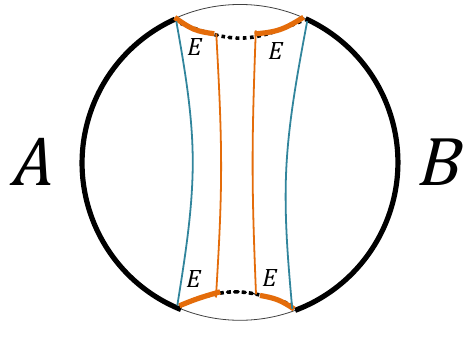
Figure 11 . A proof of I ( A : B j E ) (cid:21) I ( A : B ) for an extension (cid:26) ABE , where E is on the minimal puri(cid:12)cation (i.e. RT-surface of S AB ). The di(cid:11)erence I ( A : B j E ) (cid:0) I ( A : B ) in this case is given by the area of the orange codimension-2 surfaces minus that of the blue ones, which is certainly non-negative. For simplicity here we assumed that E is relatively small, but the same result is true for large E (i.e. near the